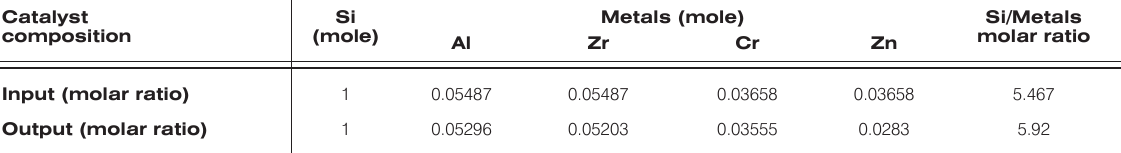
Table 2. Catalyst composition. Catalyst composition